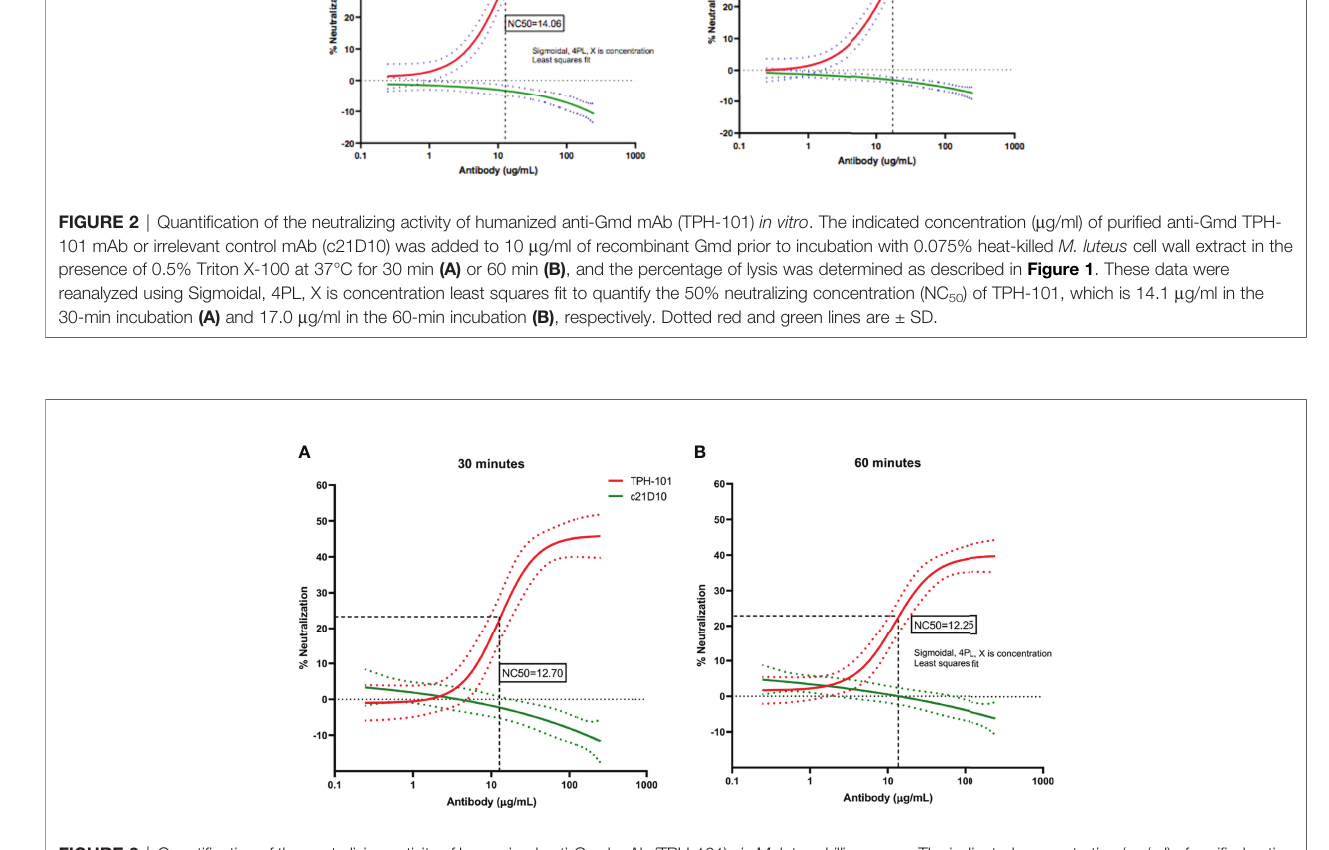
FIGURE 3 | Quanti fi cation of the neutralizingactivity of humanizedanti-Gmd mAb (TPH-101) viaM. luteus killing assay.The indicated concentration ( m g/ml) of puri fi ed anti- Gmd TPH-101 mAb or irrelevant control mAb (c21D10)was added to 10 m g/ml of recombinant Gmd prior to incubation with live M. luteus in the presence of0.5% Triton X- 100 at 37°C for 30 min (A) or60 min (B) . The percentageof neutralization was determinedas described in Material and Methods . Sigmoidal,4PL,X isconcentration least squares fi t to quantifythe 50% neutralizingconcentration (NC 50 ) of TPH-101, which is12.70 m g/ml in the 30-min incubation (A) and 12.25 m g/ml in the 60-min incubation (B) , respectively. Dotted red andgreen lines are ± SD.